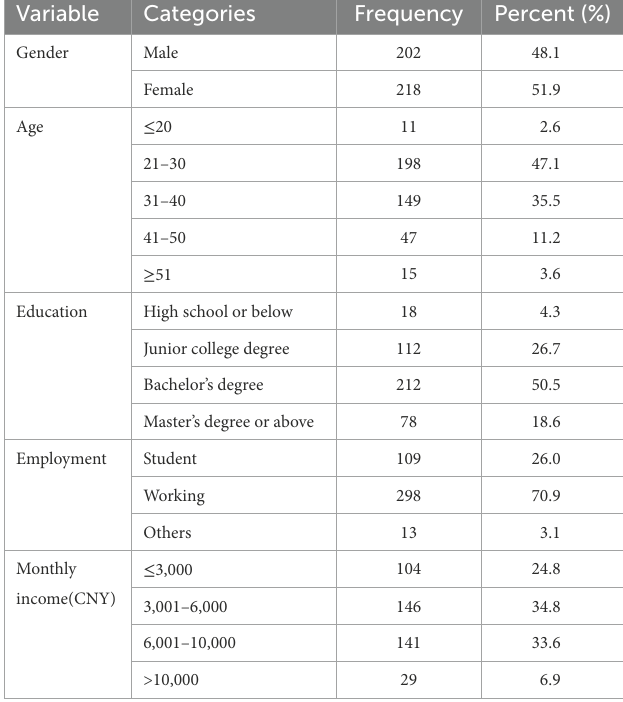
TABLE 1 Demographic characteristics of the